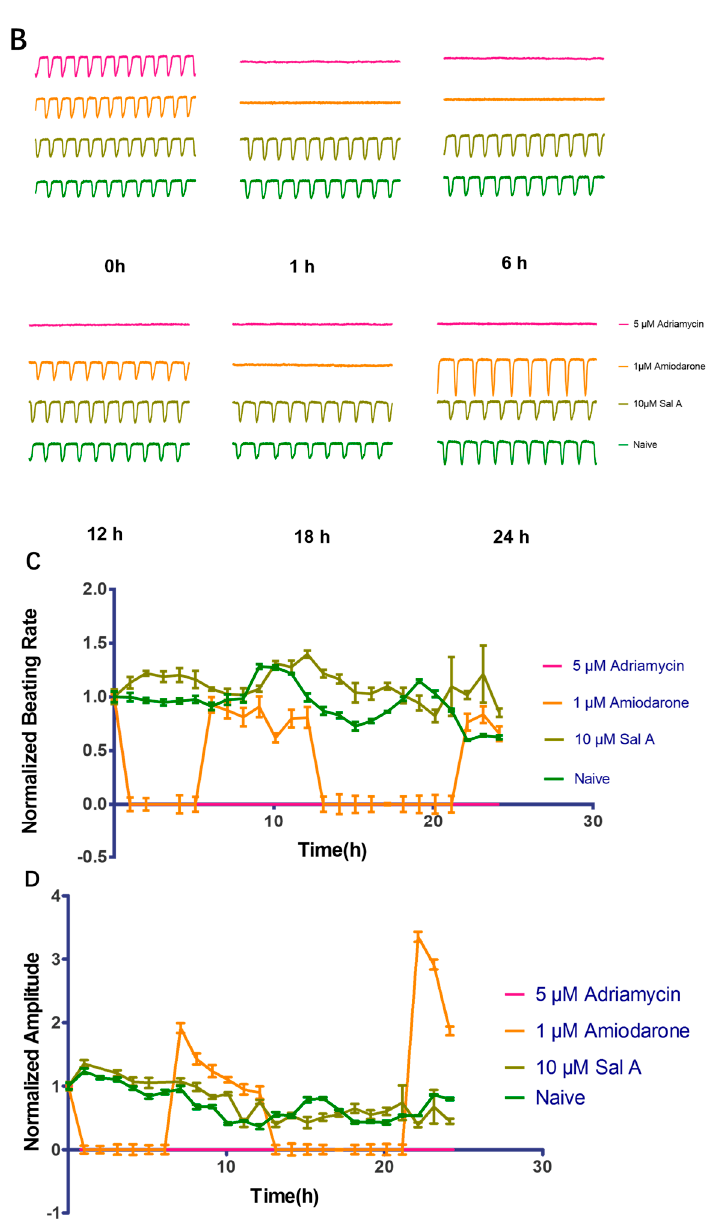
Figure 8. Typical contraction profiles of human-induced pluripotent stem cell-derived cardiomyocytes (hiPS-CMs) to compounds treatment. ( A ) Cell index fluctuation after Adriamycin (5 µM, cytotoxicity positive control), Amiodarone (1 µM, cardio-toxicity control), and Sal A (10 µM); ( B ) Temporal profiling of hiPS-CMs beating pattern. Beating pattern data were expressed in 0, 1, 6, 12, 18, 24 h; ( C ) Temporal profiling of hiPS-CMs beating rate. Data were normalized by the point before compounds were added; ( D ) Temporal profiling of hiPS-CMs amplitude. Data were normalized to the signal acquired prior to compound treatment. Data were analyzed using xCELLigence Cardio Software (ACEA, Hangzhou, China) and expressed as mean ± SD of three independent experiments.